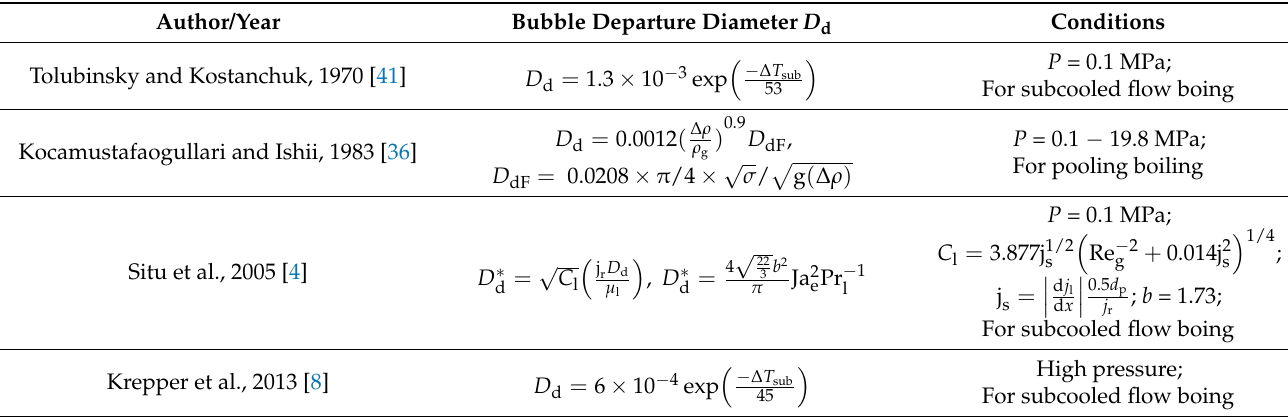
Table 3. Typical models of bubble departure diameter D d.